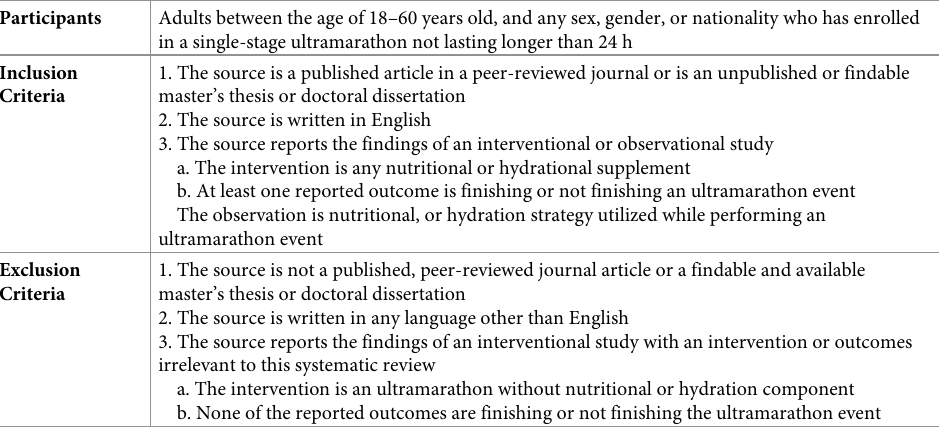
Table 2. Eligibility